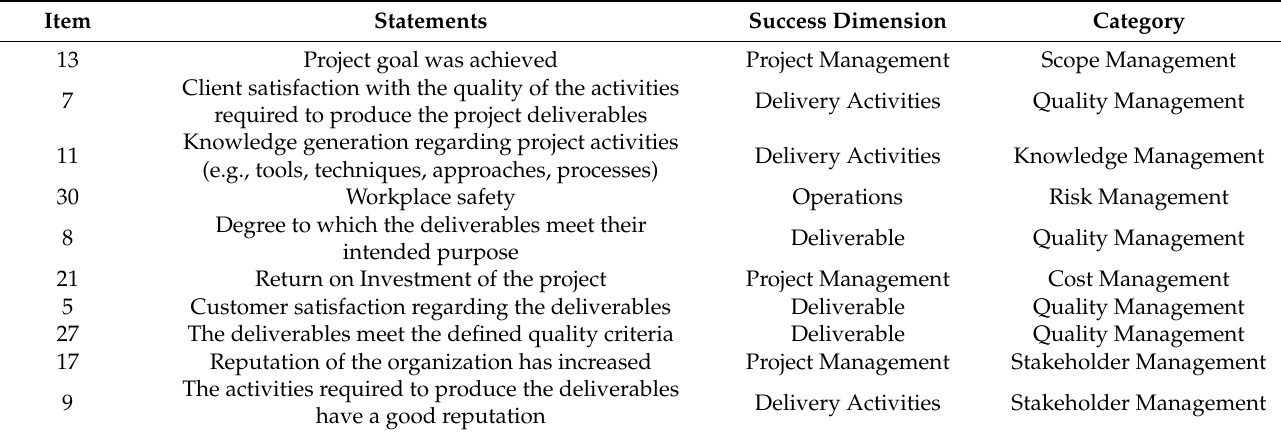
Table 10. Top-ranked statements for stakeholders and the organization.